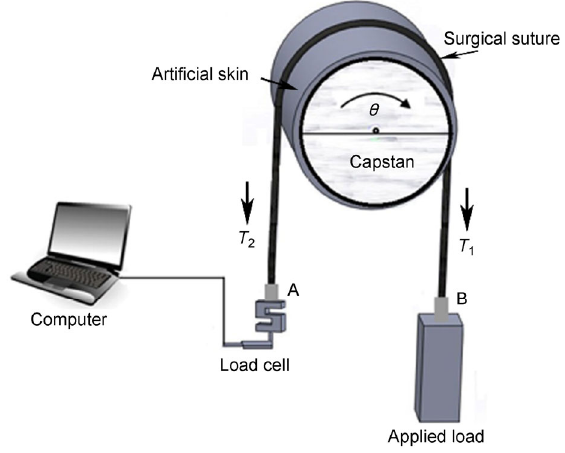
Fig. 1 Capstan experiment for friction characterization of surgical